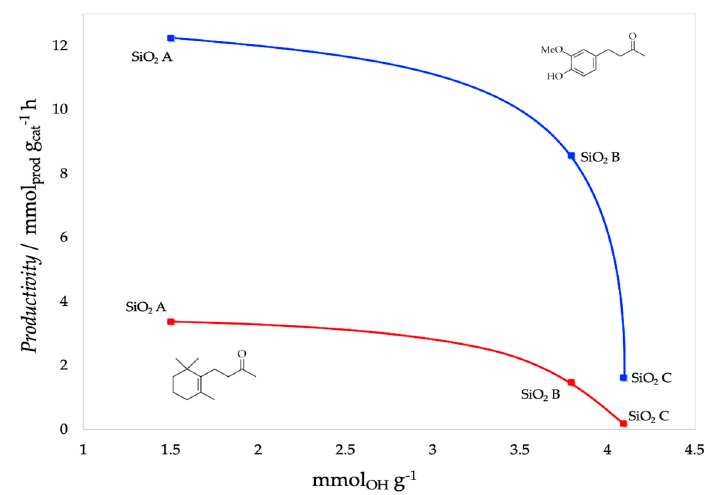
Figure 3. Productivity vs. hydroxyl group density of different silica catalysts in the hydrogenation of β -ionone and vanyllilacetone.